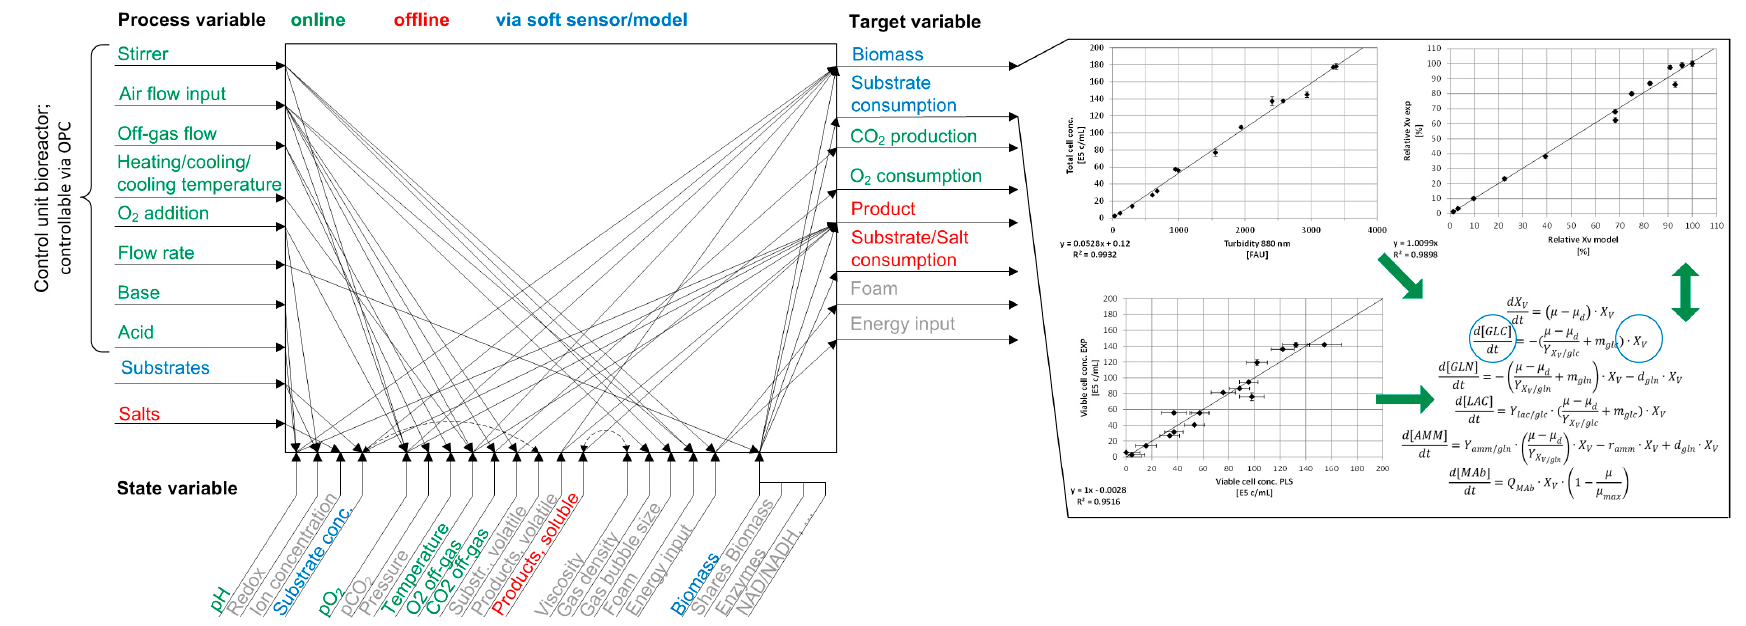
Figure 1. Main correlations between process, state, and target variables according to [22]. In this experimental set ‐ up green, red, and blue variables can be measured/controlled online, offline, or via a soft sensor/kinetic model, respectively ( left ). The target variable biomass can be measured indirectly via turbidity (linear correlation) or Raman spectroscopy (PLS). The substrate consumption, e.g., glucose, can be calculated due to the relationship between cell and substrate concentration in a macroscopic model based on Monod equations ( right ).